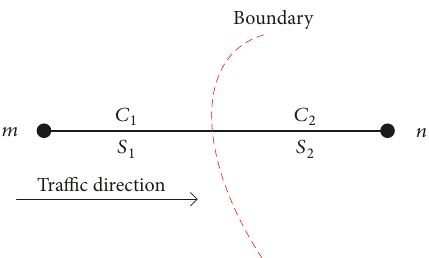
Figure 1: Concentration-based road risk level assessment method for evacuation traffic